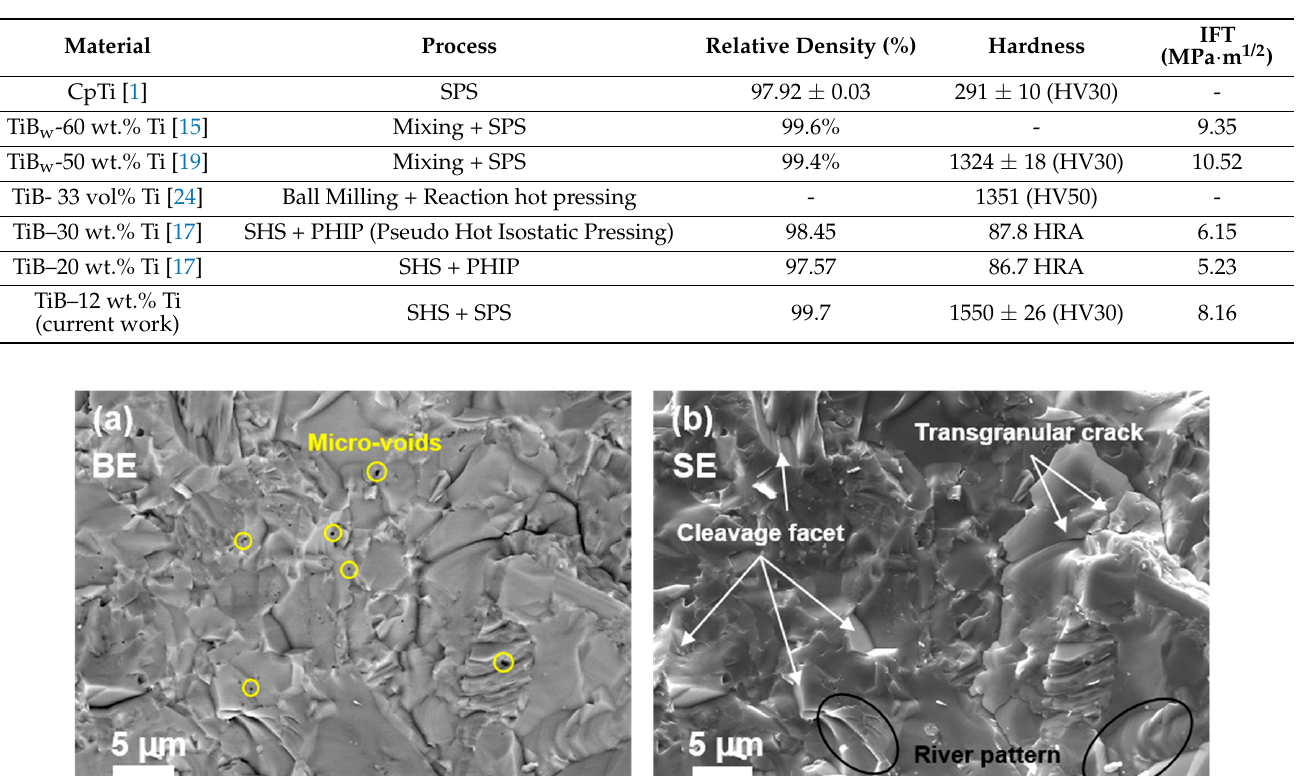
Table 2. Comparison of processing methods, relative density, hardness and indentation fracture toughness of Ti-TiB composites.